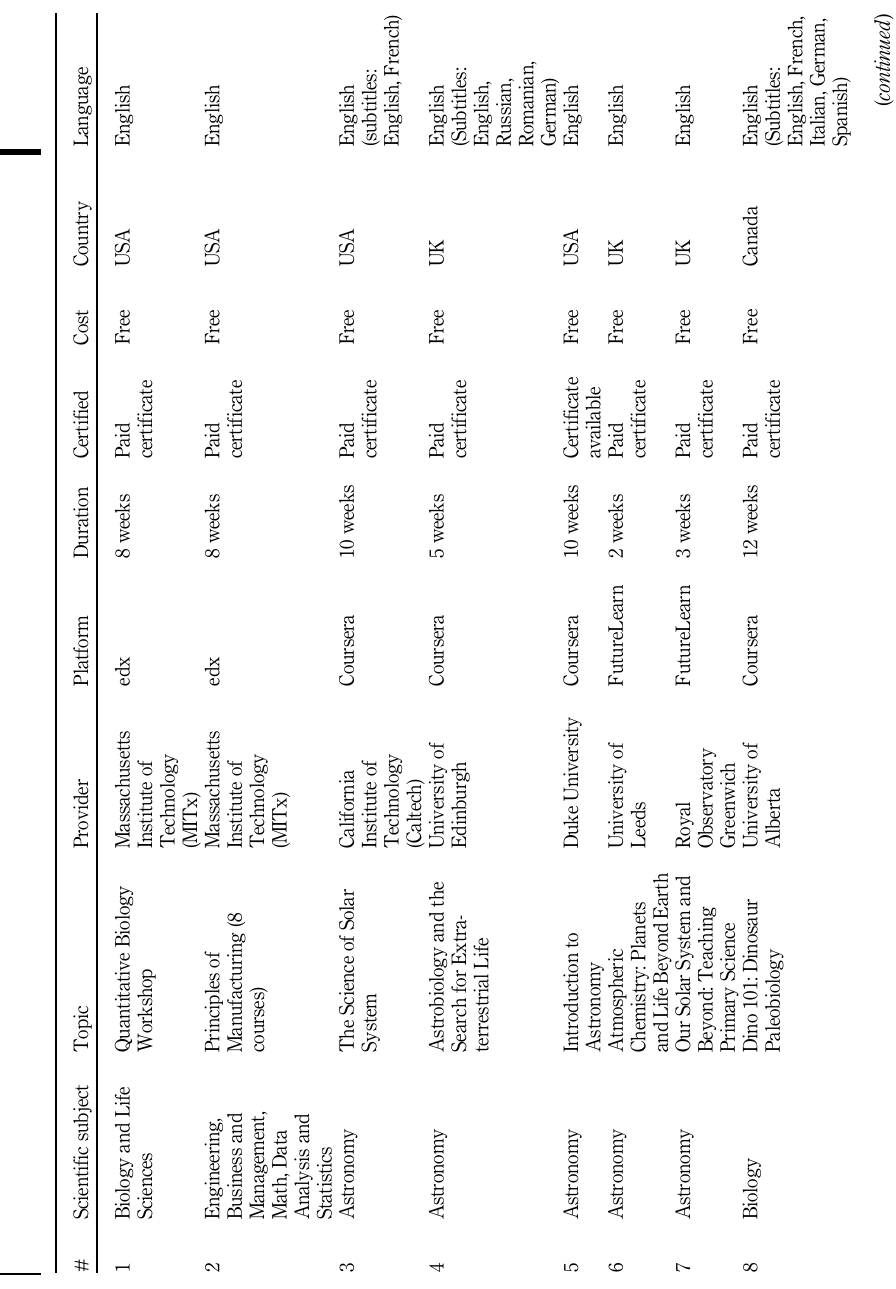
Table AI. STEM e-courses collected